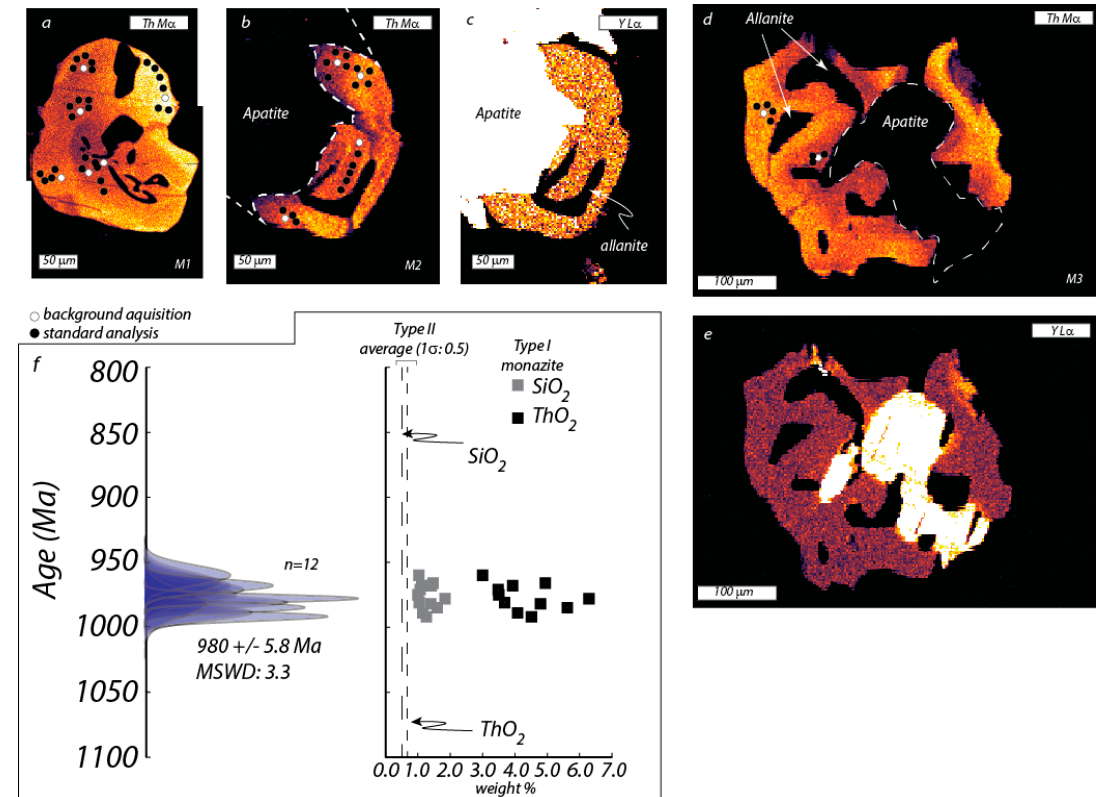
Figure 2. Wavelength-dispersive spectrometry (WDS) results for Type-I monazite. ( a – e ) WDS Th M α and Y L α beam maps of Type-I monazite; ( d ) U-Th-total Pb geochronology results plotted as Gaussian distributions with corresponding ThO 2 and SiO 2 wt. % from all type-I monazite crystals seen in histograms; dashed lines represent average composition from Type-II monazite.